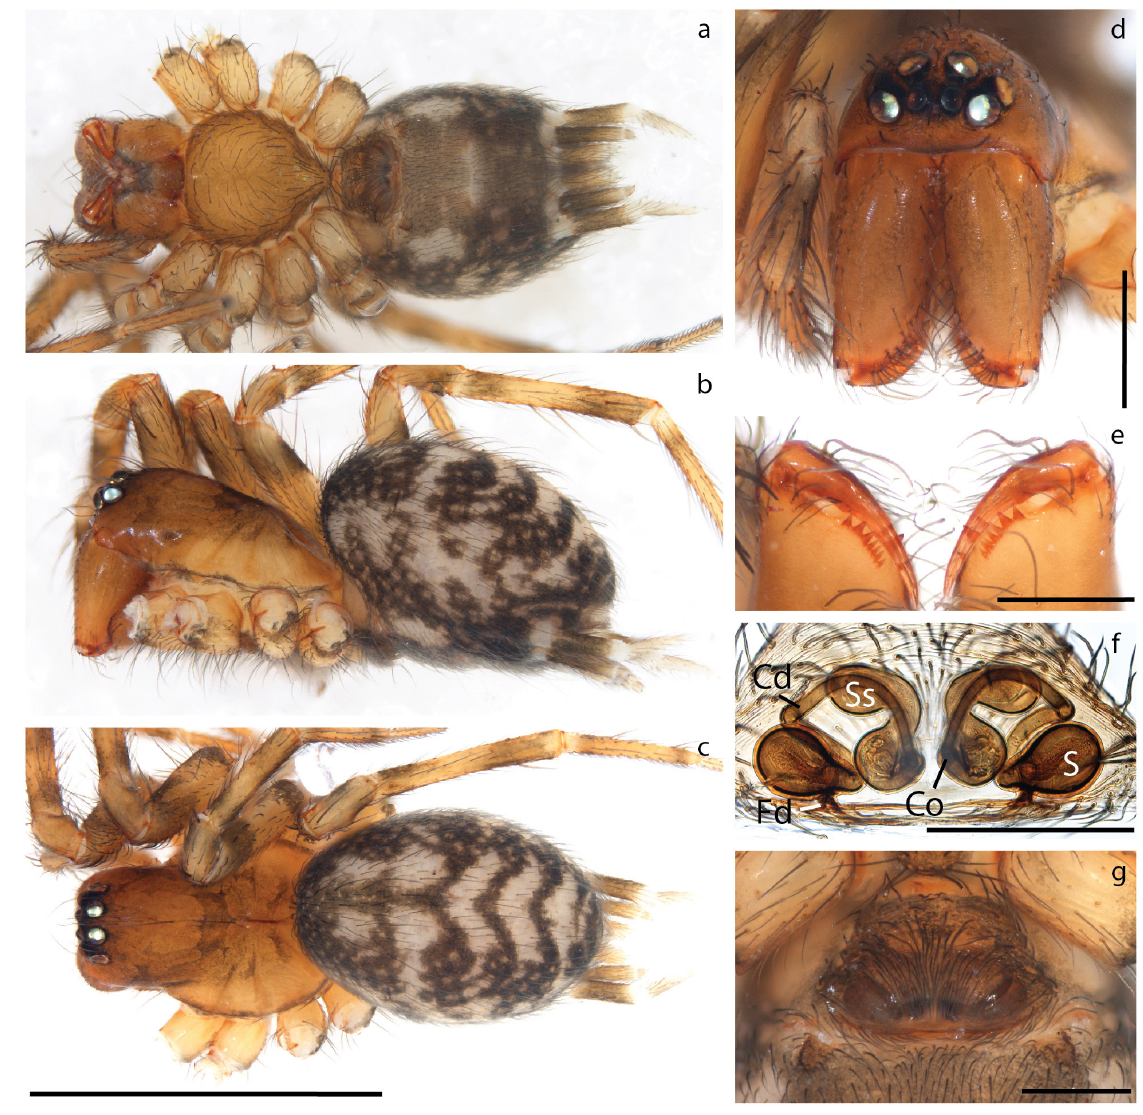
Fig. 5. Hahnia saccata Zhang, Li & Zheng, 2011, ♀ (RMNH.ARA.18412). a–c . Habitus. a . Ventral view. b . Lateral view. c . Dorsal view. d . Prosoma, anterior view. e . Chelicerae, posterior view. f–g . Epigynum. f . Dorsal view, cleared. g . Ventral view. Scale bars: a–c = 1.0 mm; d = 0.50 mm; e–g = 0.25